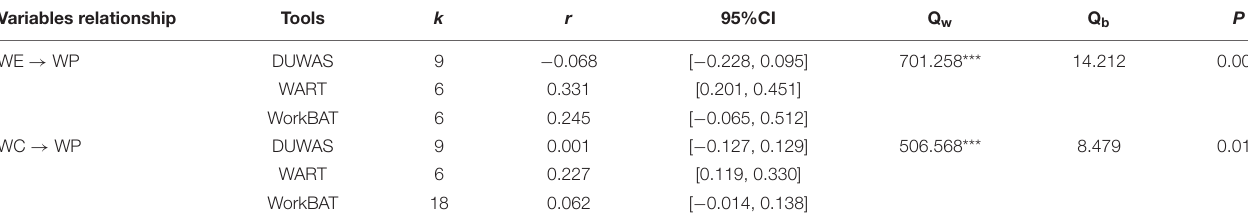
TABLE 6 | Moderator effect of the measurement tools of workaholism on the relationship between workaholism and work performance. Variables relationship